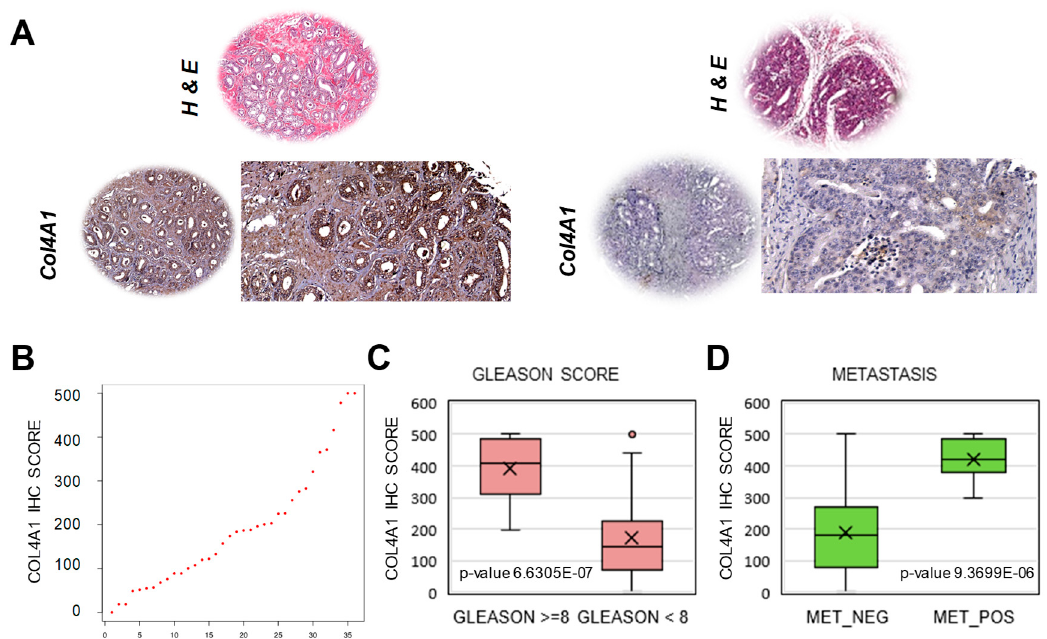
Figure 6. Orthogonal validation of low luminal marker COL4A1 in hormone-naïve primary prostate tumors. ( A ) COL4A1 protein was assessed by immunohistochemistry on a tissue microarray (TMA) containing primary prostate tumor samples. Representative images of high (left) and low (right) intensity staining. Magnification, 4 × (left and upper images) and 20 × (right image). ( B ) Distribution of COL4A1 immunohistochemistry (IHC) scores in primary tumors ( n = 46). ( C , D ) Significant association of COL4A1 IHC staining with Gleason score ( C ) and metastasis ( D ) in primary prostate